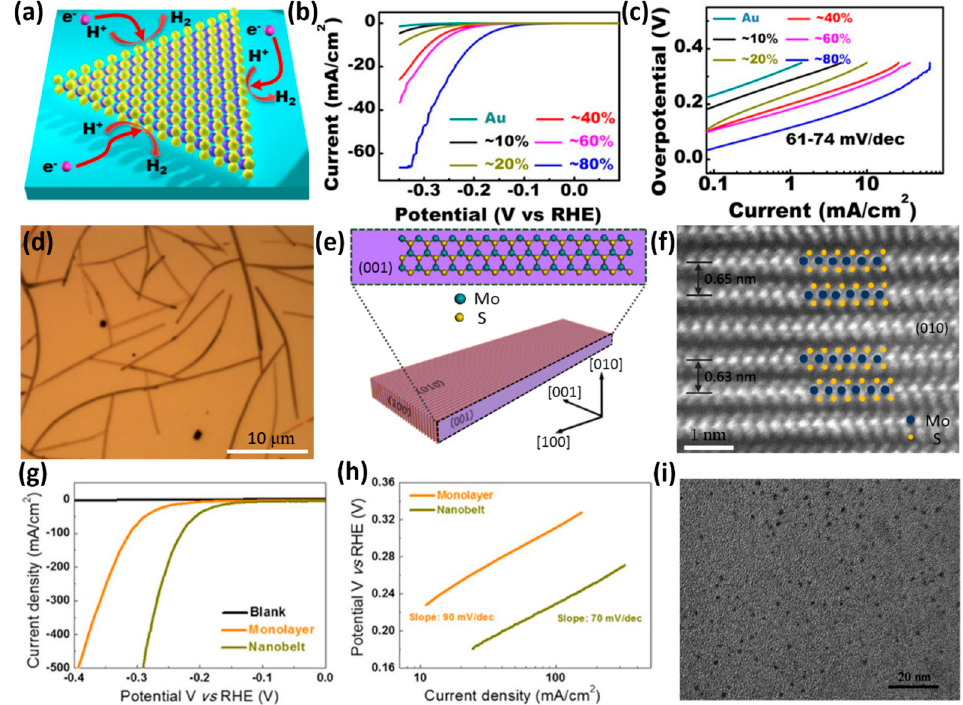
Figure 5. ( a ) Schematic illustration of the HER catalytic activity in the monolayer MoS 2 [52]. ( b ) Polarization curves and ( c ) Tafel plots of monolayer MoS 2 on Au foils with different coverage [52]. ( d ) Optical image of MoS 2 nanobelts [53]. ( e ) Schematic illustration and ( f ) HRSTEM image of MoS 2 nanobelts [53]. ( g ) Polarization curves and ( h ) Tafel plots of monolayer MoS 2 and MoS 2 nanobelts [53]. ( i ) TEM image of the MoS 2 nanoparticles [54]. Reproduced from [52,53] with permission from American Chemical Society and [54] with permission from copyright 2013 The Royal Society of